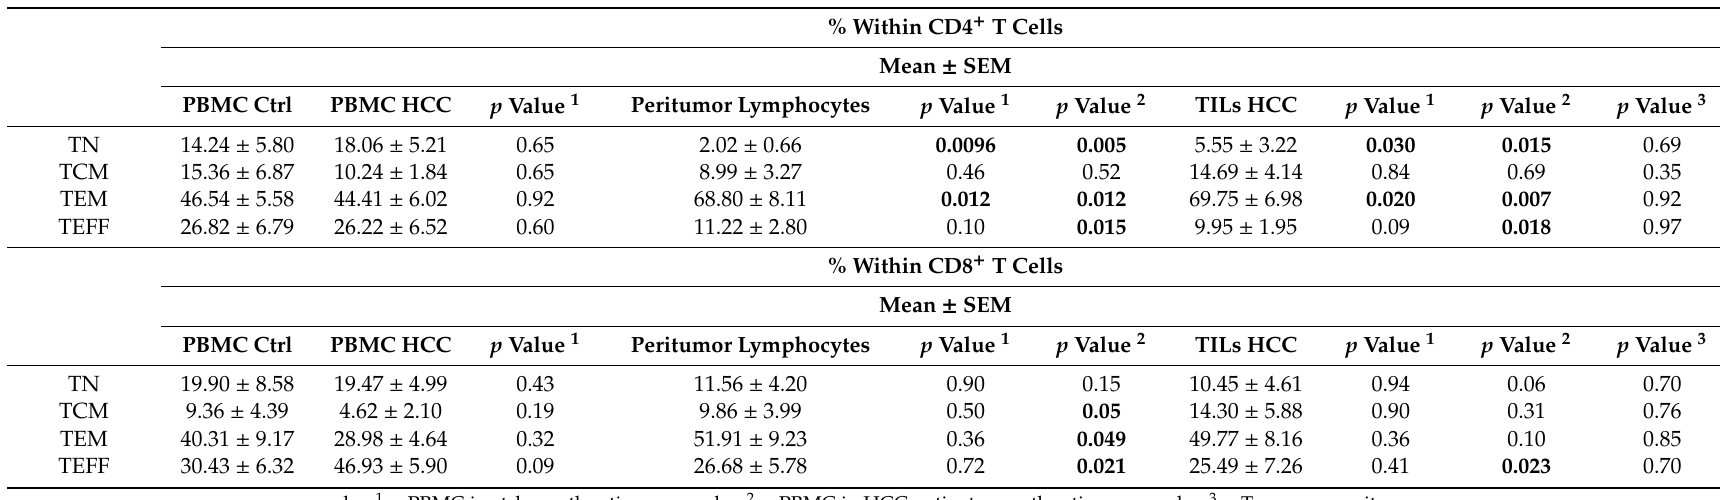
Table 4. T cell subsets. TEFF = Terminally di ff erentiated CD4 + and CD8 + e ff ector T cells. TEM = E ff ector memory CD4 + T